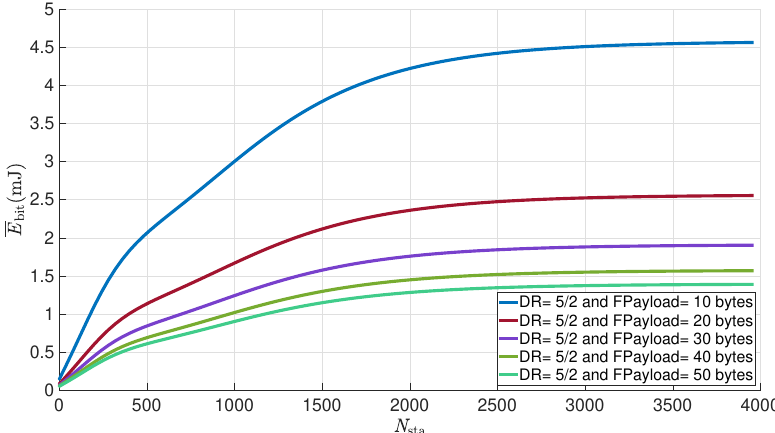
Figure 18. Average energy consumed per useful bit by a LoRa sensor for various payload sizes vs. number of nodes in the network (NR = 8; P tx = 14 dBm; d = 1 km; dc = 1%).